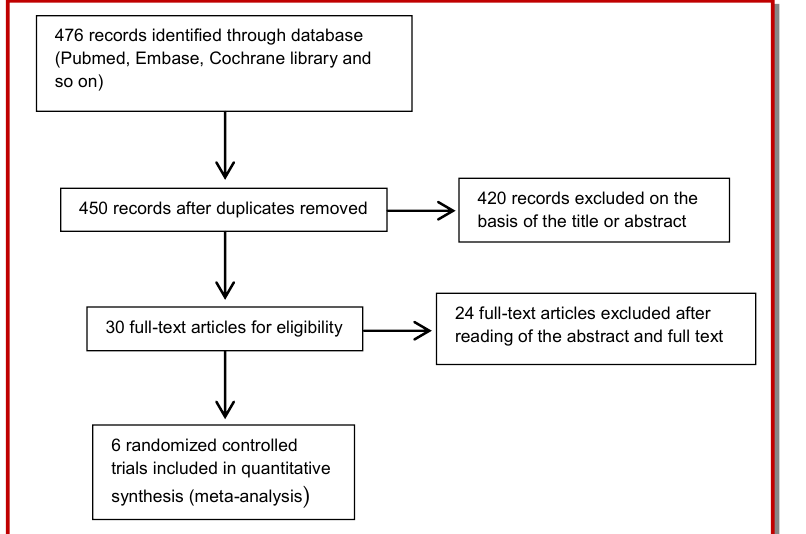
Figure 1: Flow-chart diagram of study selection. Finally, six eligible full-text articles were retrieved